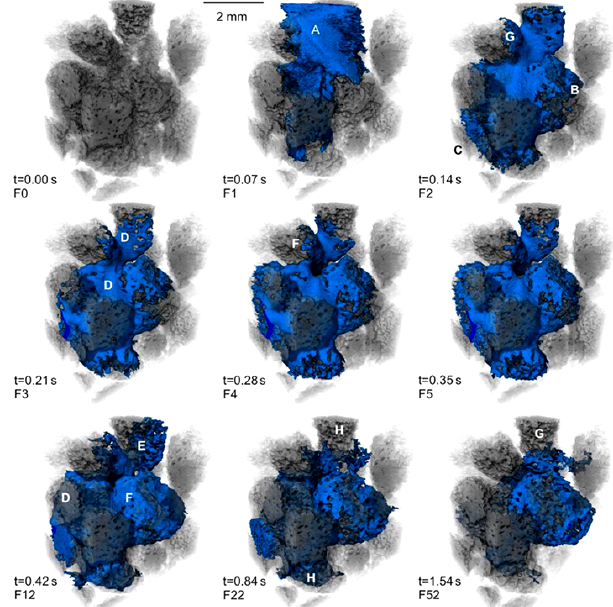
Figure 2. The fluid phase in the rock sample at three different times of the water ingress. Each volume is reconstructed from 60 projec- tions using the CGLS-NLST method (Kaestner et al., 2015).